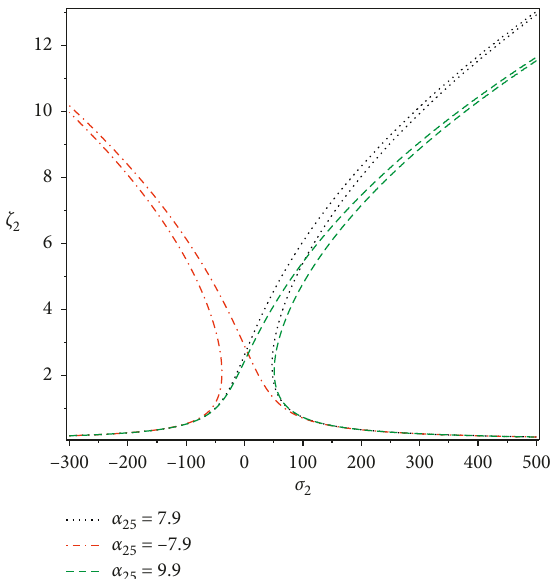
Figure 11: Frequency-response curves in the z direction with the nonlinear